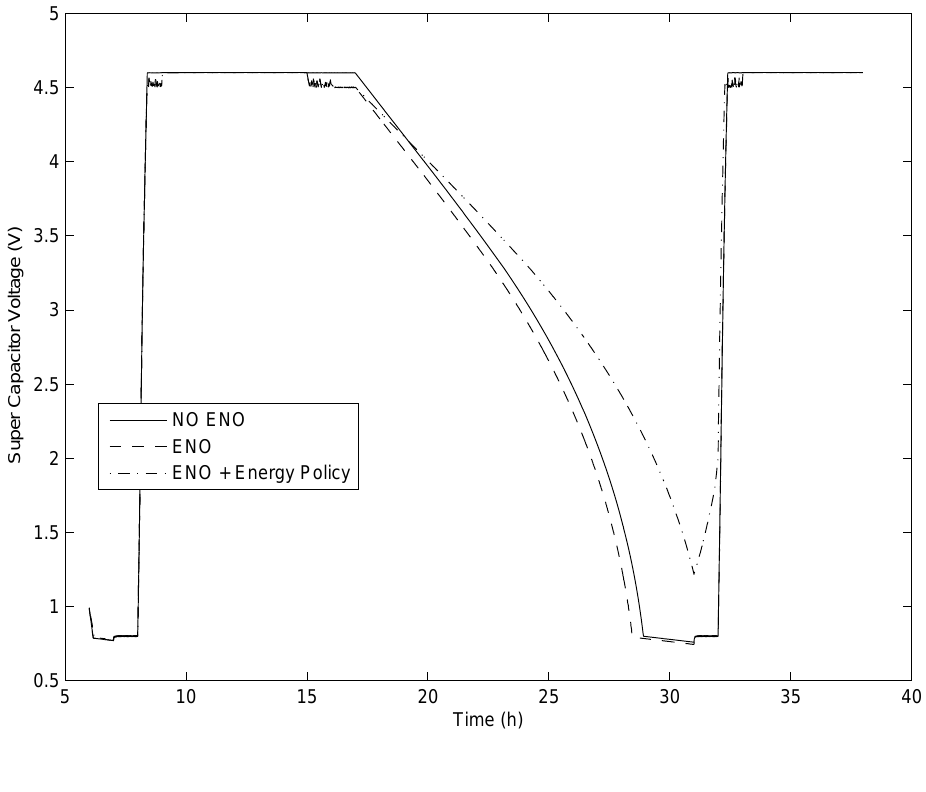
Figure 8. Comparison of energy-neutral operation (ENO) and NO ENO